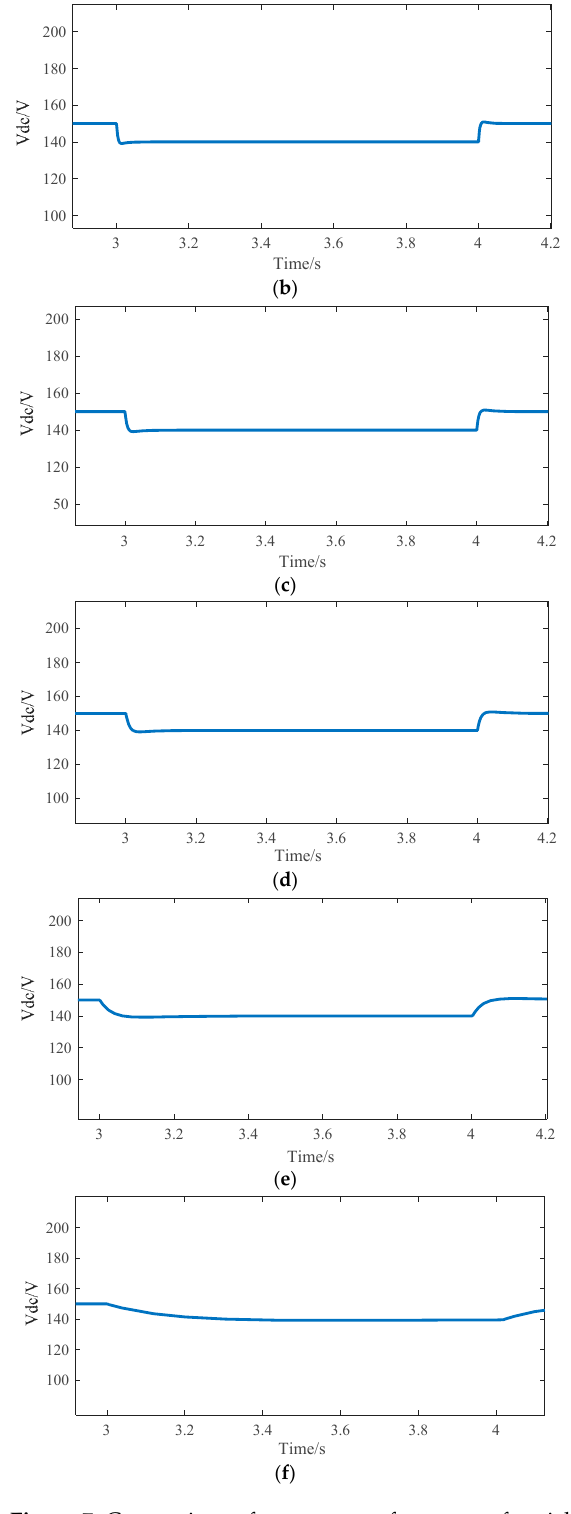
Figure 7. Comparison of response performance of variable droop coefficient. ( a ) Q 2 = 1. ( b ) Q 2 = 5. ( c ) Q 2 = 10. ( d ) Q 2 = 20. ( e ) Q 2 = 50. ( f ) Q 2 = 100.